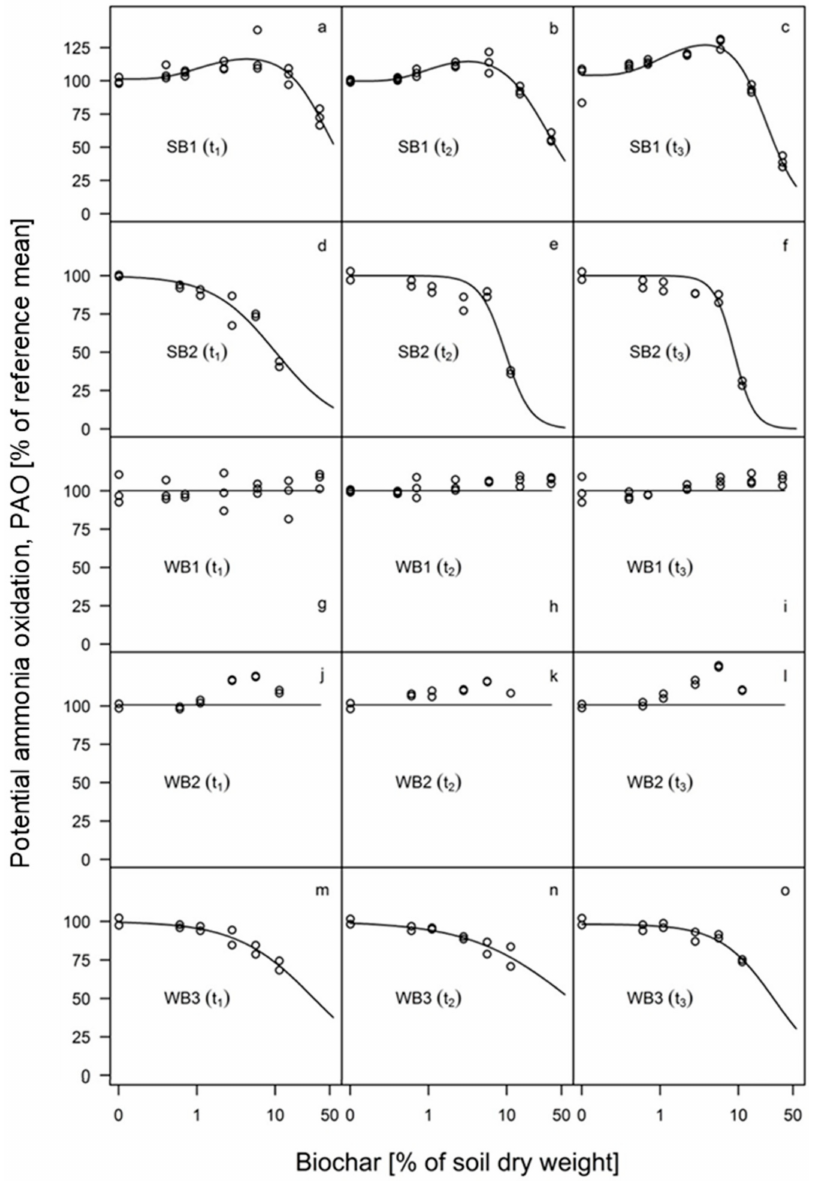
Figure 2. Dose-effect of biochars on potential ammonium oxidation (PAO) in agricultural soil. PAO assays were made after soil/biochar interaction for 1–2 days ( t 1 ; left panels), 1 week ( t 2 ; middle pan- els), and 3 weeks ( t 3 ; right panels). Data are shown as percent of the means of uninhibited references (100%). SB1, SB2—straw biochars; WB1, WB2—pine wood biochars; WB3—oak wood biochar. The fitted model parameters in Equations (1) and (2) were always significant ( p < 0.05), except for the E parameter (EC 50 estimation) for WB3 after 1 and 3 weeks of soil/biochar in- teraction ( p > 0.11). Too few data points at the lower response level caused this uncertainty. Soil pH(CaCl 2 ) systematically increased with increasing rates of biochar, notably for the two straw biochars, SB1 and SB2 (Figure 3). At biochar rates of less than 1.1%, which are realistic for field application to the plough layer (0–20 cm), the pH increase was generally moderate (0.1–0.3 units), yet with an increase of 0.9 pH units for SB2. At the extraordinarily high rates of biochar (>10%), both SB1 and SB2 increased the soil pH to 7.5–8.5. The pine wood biochars WB1 and WB2 caused an intermediate pH response, whereas the low-temperature oak wood biochar WB3 caused minor increases (<0.4 pH units), even at >10% biochar (Figure